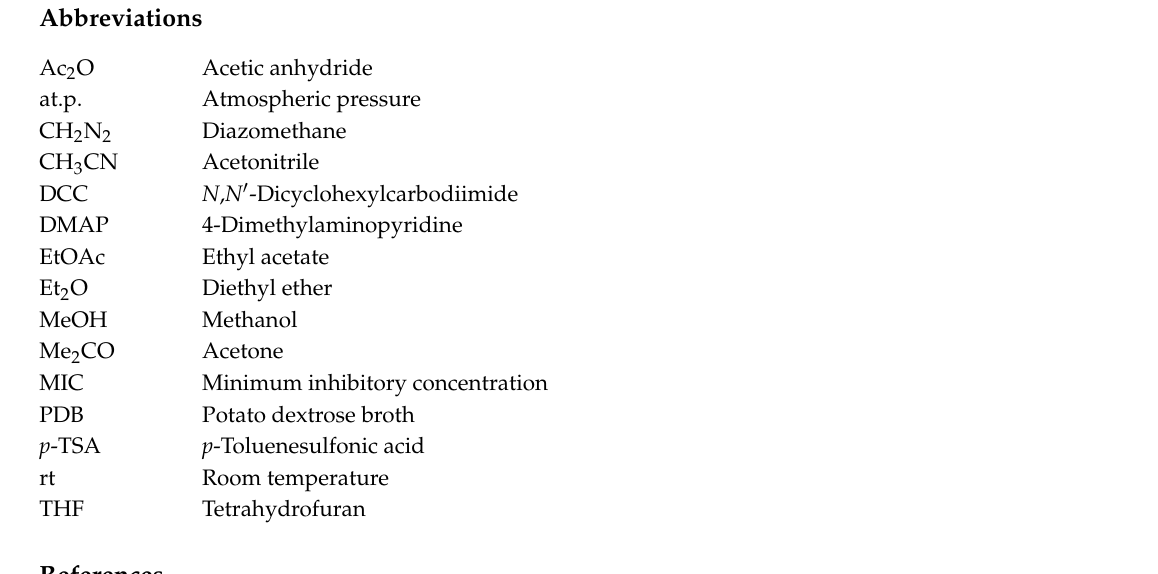
Supplementary Materials: A table (Table S1) with all the fungal metabolites cited in the text, their hemisynthetic derivatives and the relative biological activities is reported in the Supplementary Materials available